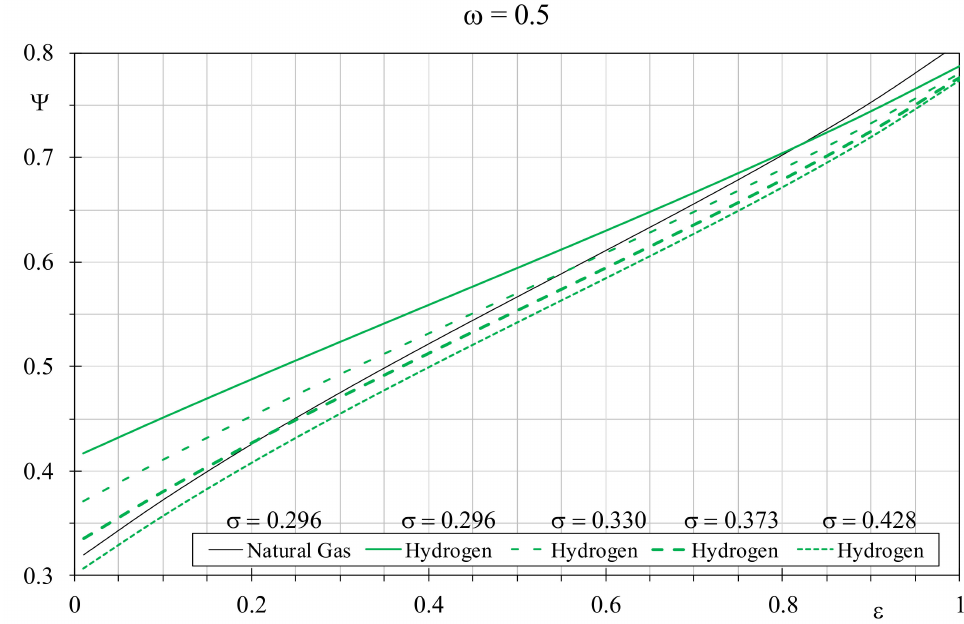
Figure 5. Comparison of the EQI related to the boiler heat exchanger efficiency between Natural Gas and Hydrogen, with different value of the dimensionless temperature factor and setting ω =